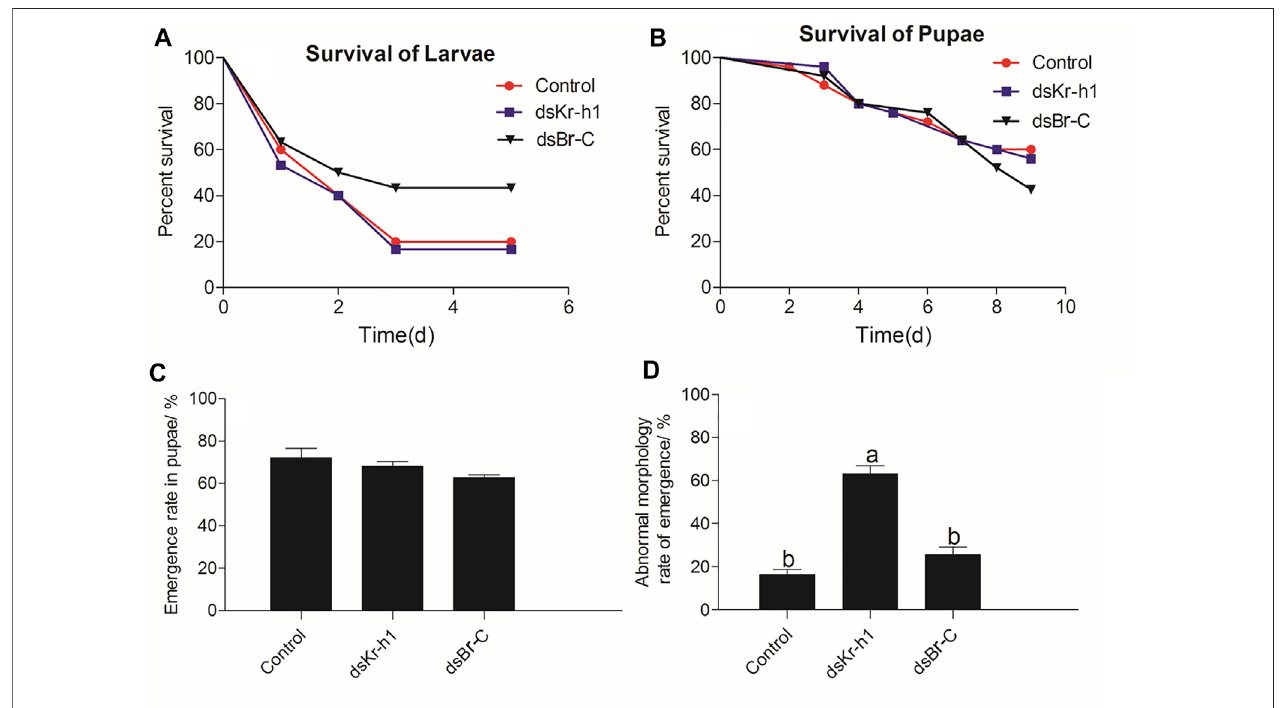
FIGURE 9 | Survival, emergence, and abnormal morphology rates of D. armandi after RNAi. (A) Survival rate of larvae. (B) Survival rate of pupae. (C) Emergence rate of pupae. (D) Abnormal morphology rate of pupae. Each biological repetition had 25 samples. The Kaplan-Meier method (log-rank Mantel – Cox test) was used to analyze the survival rate. Data of emergence and abnormal morphology rates of pupae were analyzed by one-way ANOVA. Different letters above the bars indicate that the difference was signi fi cant at p < 0.05.